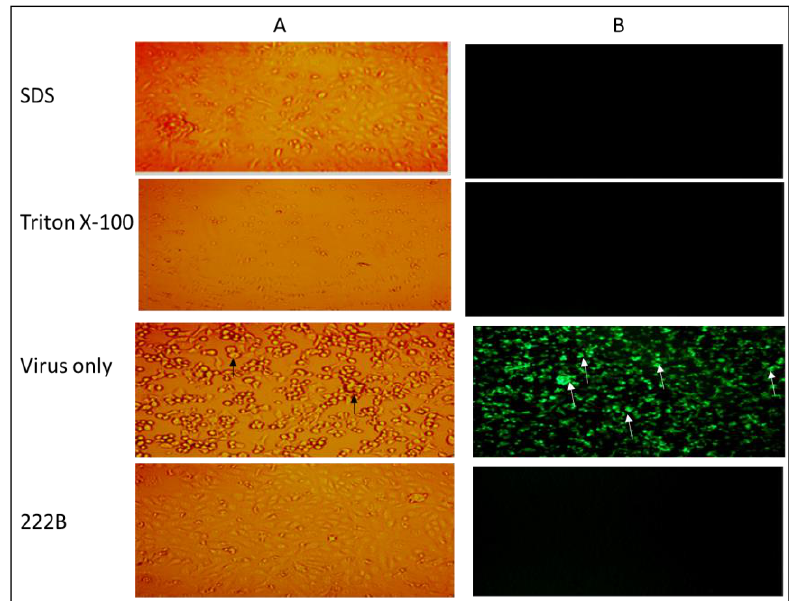
Figure 4. Bright light ( A ) and fluorescence ( B ) images of Vero cells infected with HSV-1-GPF. HSV-1-GPF at ~1 × 10 5 PFU/well was inoculated to Vero cells in the presence of SDS, Triton X-100, 222B, and HSV-1 only, respectively. All surfactants were made at 0.009%% in the inoculants. A: The bright light image was captured at 10× magnification. B: Fluorescent images were captured at 20× magnification. Black arrows indicate CPE under the light microscope, such as cell rounding and aggregation in HSV-1-infected cells. White arrows indicate GFP expression from GFP-HSV-1 rep- lication under the fluorescent microscope.